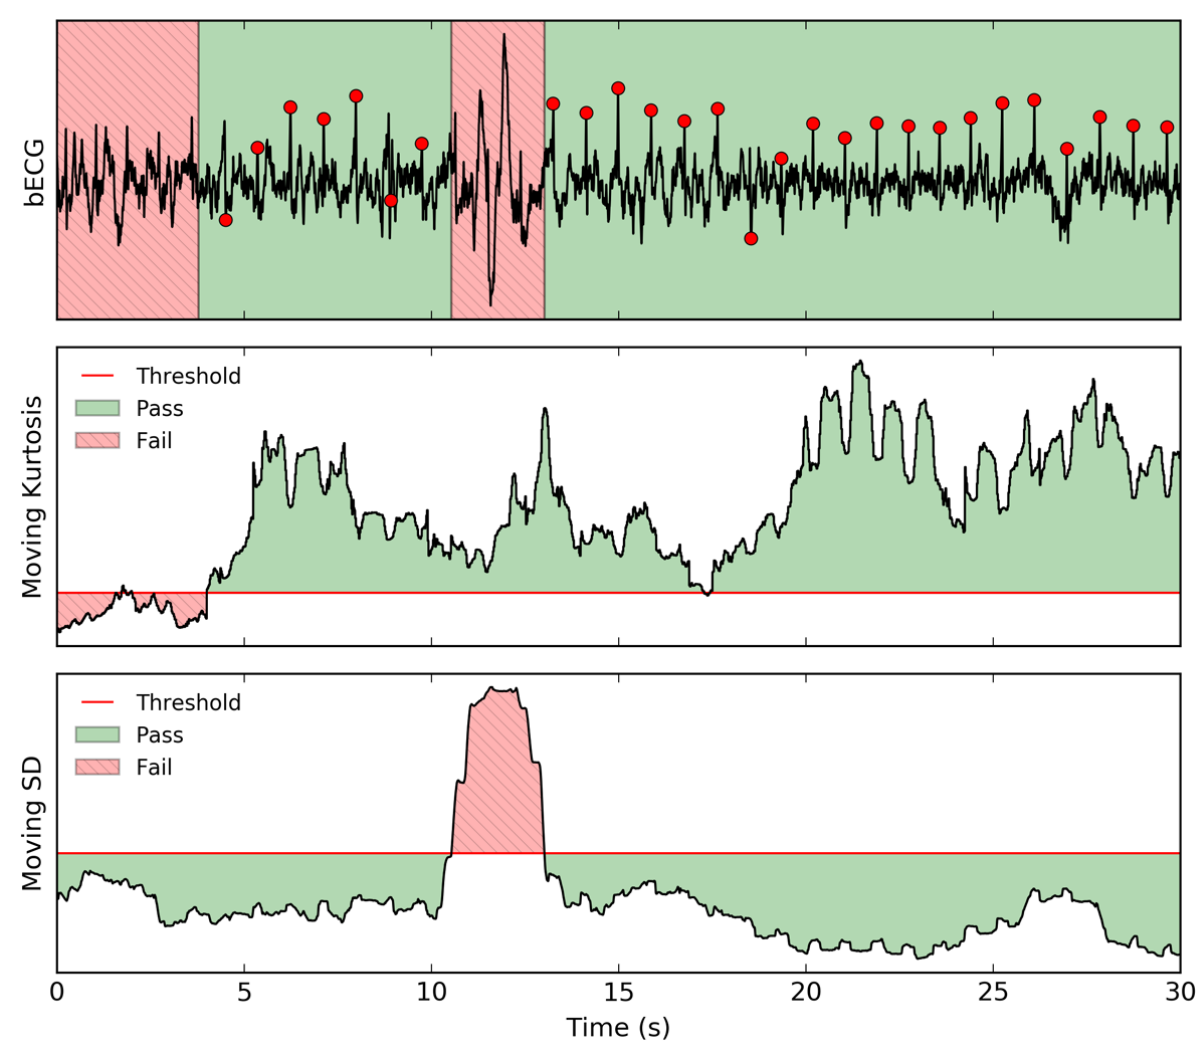
Figure 2. Signal quality is calculated from the bandpass filtered (1-45 Hz) and notch filtered (60 Hz) bECG (top) using a moving kurtosis (middle) and moving SD (bottom). The first signal quality index (moving kurtosis) rejects regions with in-band noise that have a kurtosis below a threshold of 3.6. The second signal quality index (moving SD) rejects noisy spikes that have a moving SD greater than 1.25 times the overall SD. R-peak delineations are shown as red circles to indicate where each beat is located within regions that have passed the signal quality test. bECG: buttocks